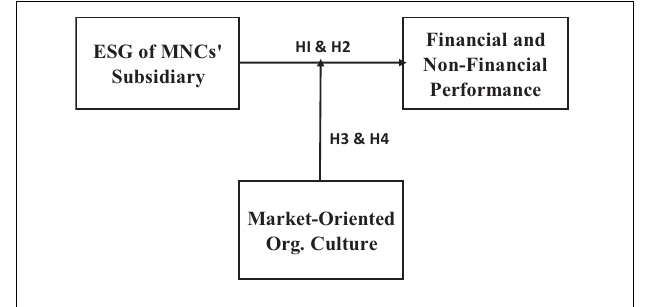
FIGURE 1 | Research